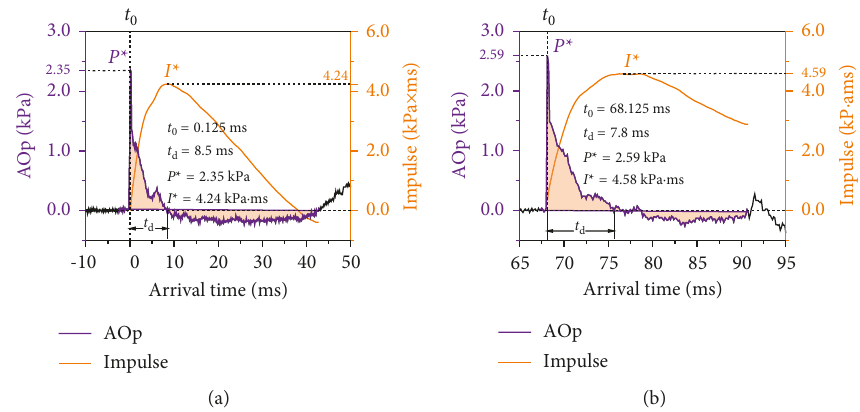
Figure 10: Time profiles of AOp and impulse: (a) Point A and (b) Point B.